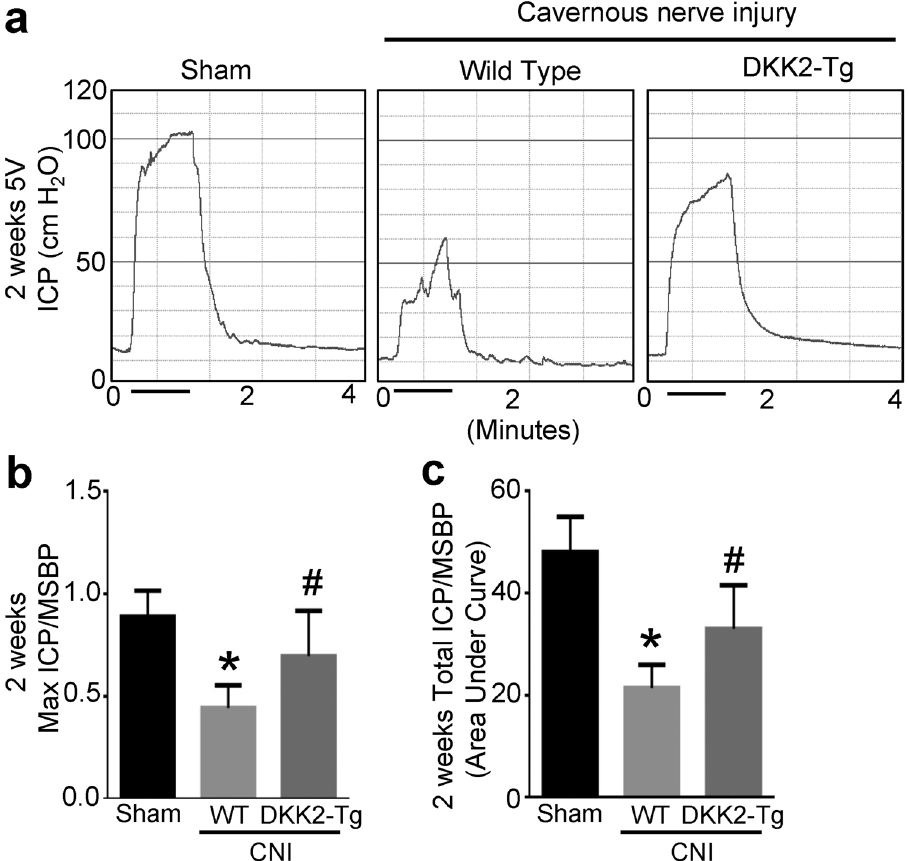
Figure 7. DKK2-Tg mice are resistant to CNI-induced erectile dysfunction. ( a) Representative ICP responses for the wild-type (WT) mice receiving sham operation, WT mice receiving CNI, or DKK2-Tg mice receiving CNI. The stimulus interval is indicated by a solid bar. The ICP was measured 2 weeks after CNI. (b , c) Ratios of mean maximal ICP and total ICP (area under the curve) to mean systolic blood pressure (MSBP) were calculated for each group. Each bar depicts the mean ( ± SE) values from n = 6 animals per group. * P < 0.001 vs. WT + sham operation group, # P < 0.05 vs. WT + CNI group. CNI = cavernous nerve injury; DKK2-Tg = dickkopf2-transgenic